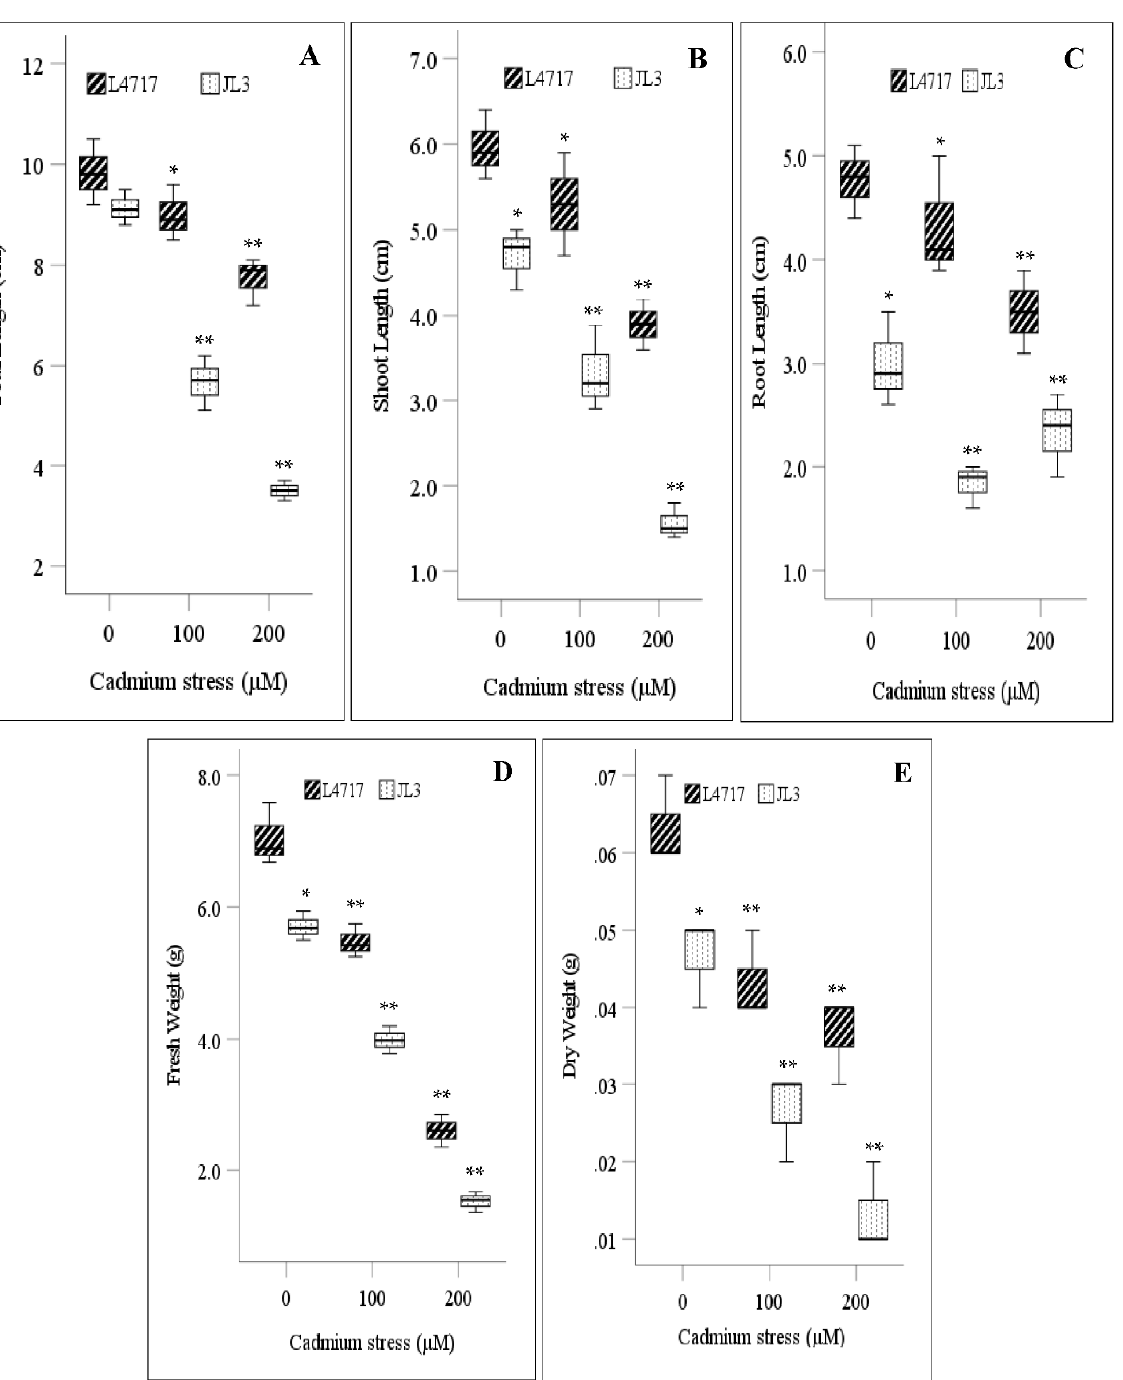
Figure 2. Changes in ( A ) total length, ( B ) shoot length, ( C ) root length, ( D ) fresh weight, and ( E ) dry weight of lentil seedlings under Cd stress. The central bar in each box represents the median, and each box shows the interquartile range. * and ** indicate significant differences among treatments at p < 0.05 and p < 0.01, respectively. The genotypic means for SL and RL declined by 19.1% and 2.7% at 100 μ M Cd, and 48.8% and 2.7% at 200 μ M Cd, respectively. Genotype and treatment differences were significant for both traits at p < 0.01, while their interaction was significant at p < 0.05 (Table 2). SL and RL declined more in JL3 than L4717 in both Cd treatments (Figure 2B,C). For L4717, RL declined more at 100 μ M Cd than 200 μ M Cd; for JL3, RL declined with increasing Cd level. SL decreased in both genotypes with increasing Cd level. Total biomass (FW and DW) declined significantly in both genotypes under Cd stress (Figure 2D,E). Genotype and treatment differences were significant at p < 0.01, while their interaction was significant at p < 0.05 (Table 2). The genotypic mean for FW and DW de- clined by 25.8% and 37.2% at 100 μ M Cd and 54.1% and 60.2% at 200 μ M Cd, respectively. FW declined more in JL3 than L4717 (73.3% vs. 49.6%), relative to the controls under high Cd conditions (Figure 2D). DW declined by 36.8% in L4717 and 71.4% in JL3 at 200 μ M Cd (Figure 2E). 3.3. Cd Uptake Significant differences ( p < 0.01) in total Cd accumulation occurred for genotype, treatment, and their interaction (Table 2). JL3 had greater Cd uptake than L4717 in both Cd treatments—42.1% higher at 100 μ M Cd and 103.2% higher at 200 μ M Cd (Figure 3).